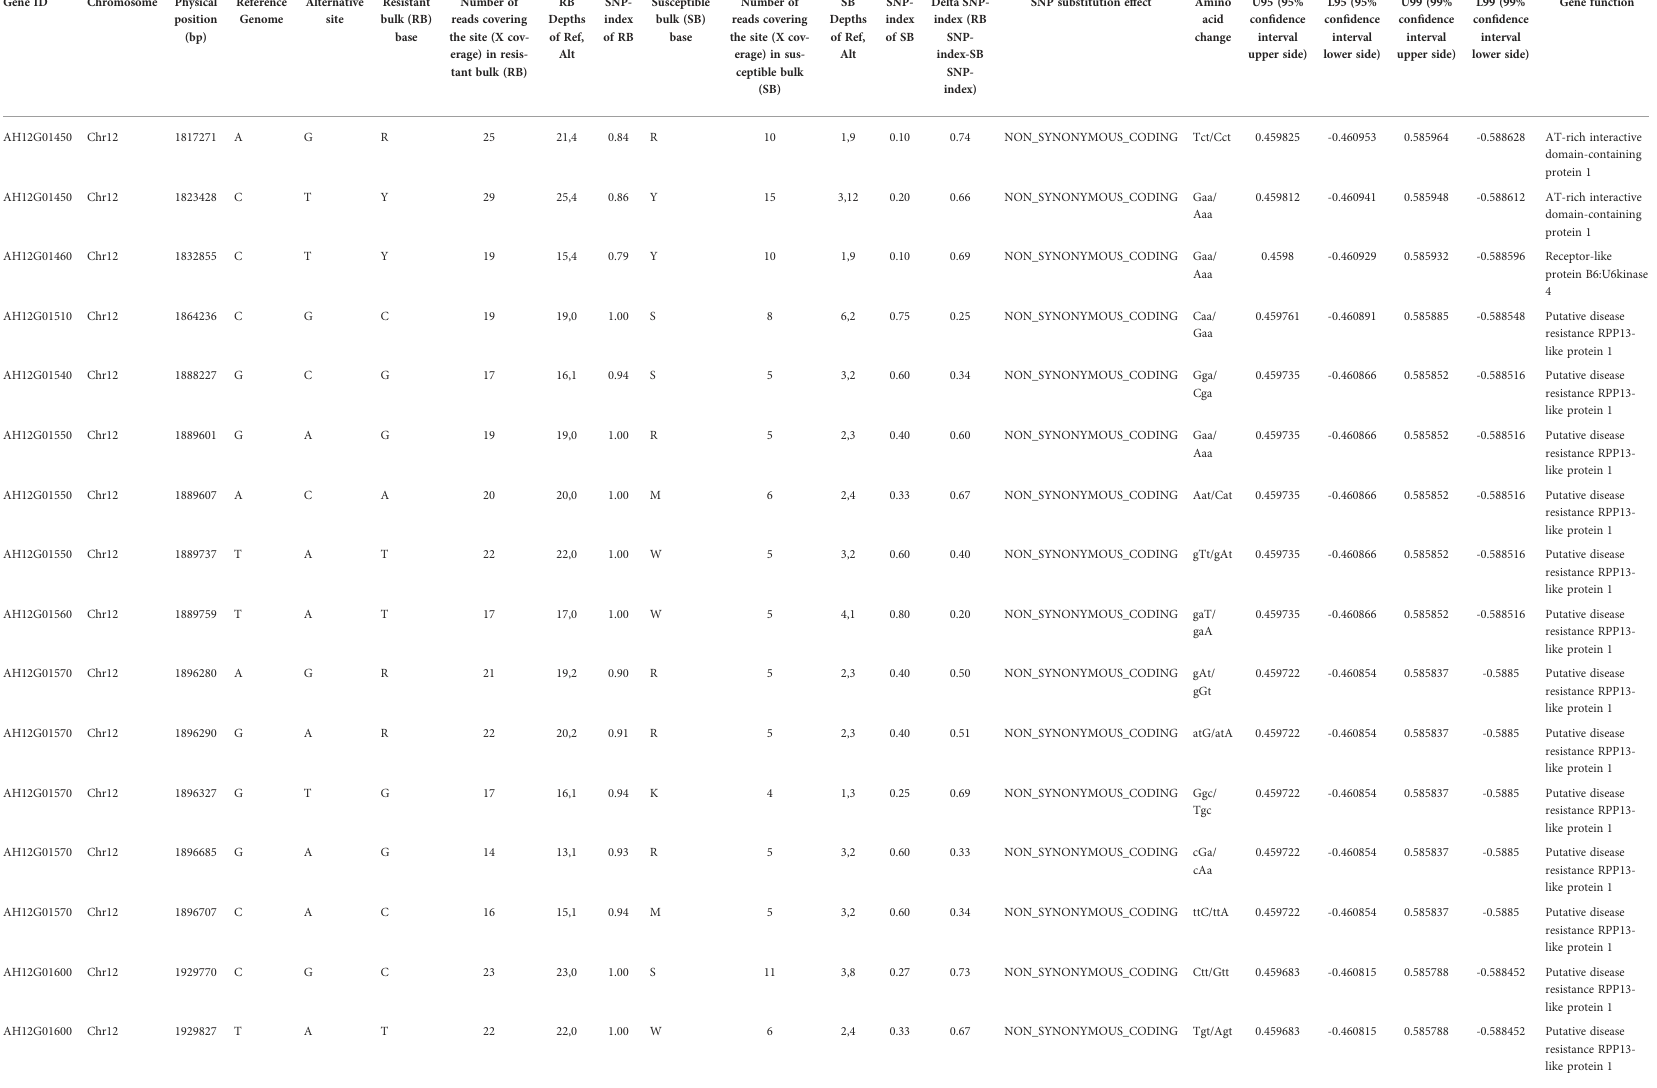
TABLE 2 Identi fi cation of SNPs in putative candidate genes in the genomic region for resistance to on chromosome 12. Gene